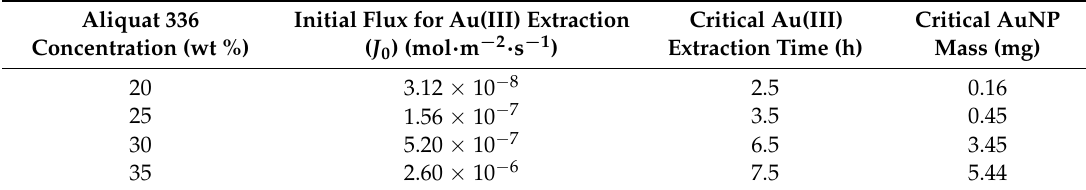
Table 1. “Critical AuNP masses”, initial Au(III) flux values, and “critical” Au(III) extraction (loading) times of PIMs for different concentrations of Aliquat 336.